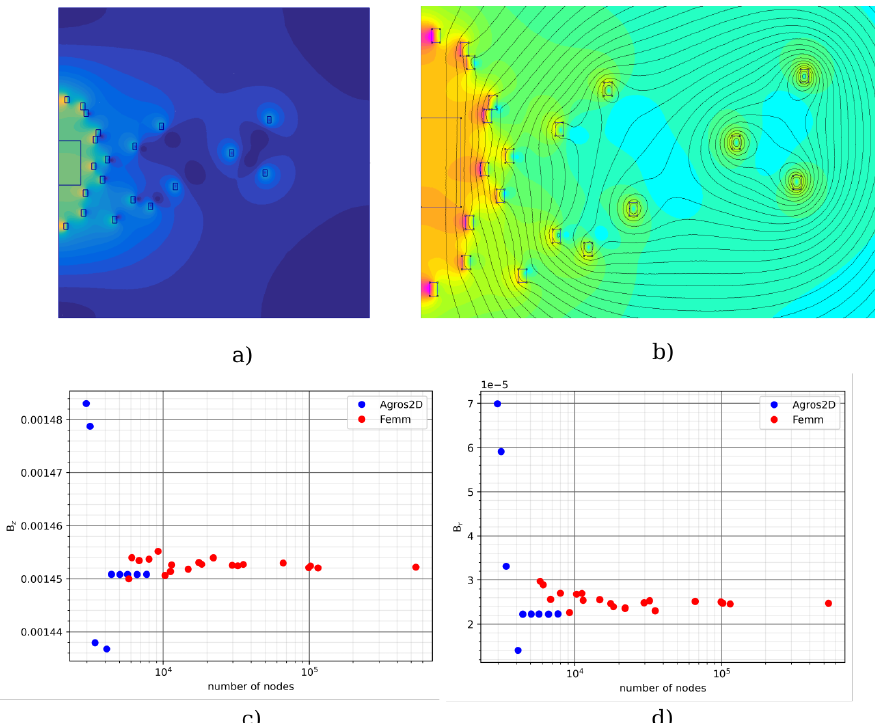
Figure 3. The pictures ( a , b ) show the geometry examined and the resulting flux distribution with the Agros2D ( a ) and FEMM software ( b ). The pictures ( c , d ) show the convergence of the radial and the axial component of the flux density in the selected ( r = 5 mm, z = 5 mm)